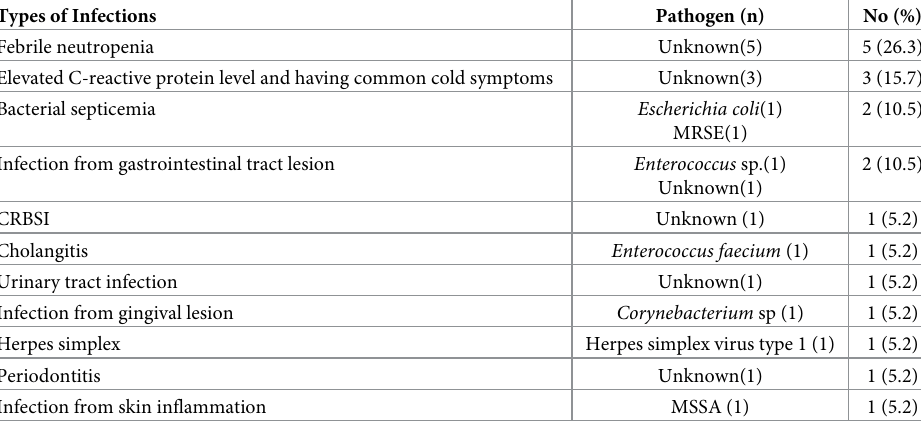
Table 4. Types of infections and